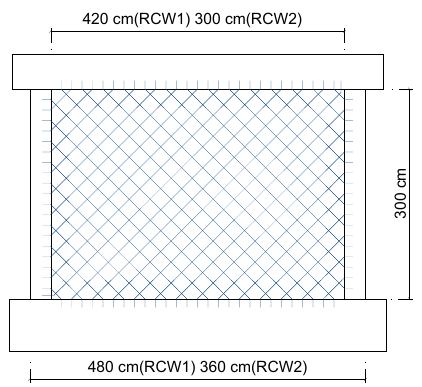
Figure 3. Dimensions of the specimens of RCW1 and RCW2. (unit: cm).